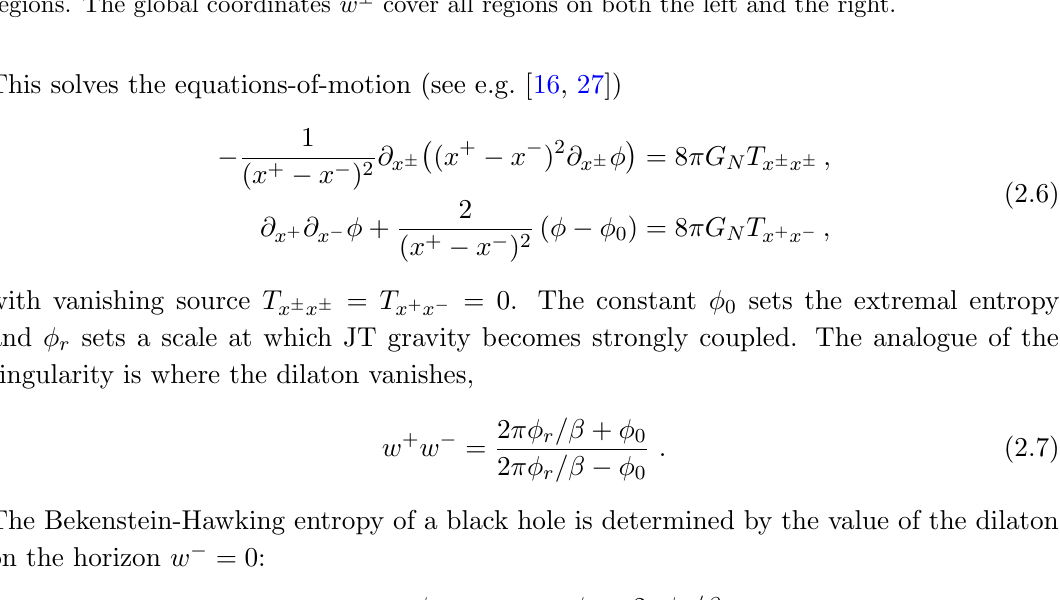
Figure 1 . The coordinates of the eternal black hole pair along with their half-Minkowski space bath regions. The pink region is part of the AdS geometry outside the right black hole. The yellow region is the right bath region. The right Schwarzschild coordinates y (cid:6) cover the pink and yellow regions. The global coordinates w (cid:6) cover all regions on both the left and the